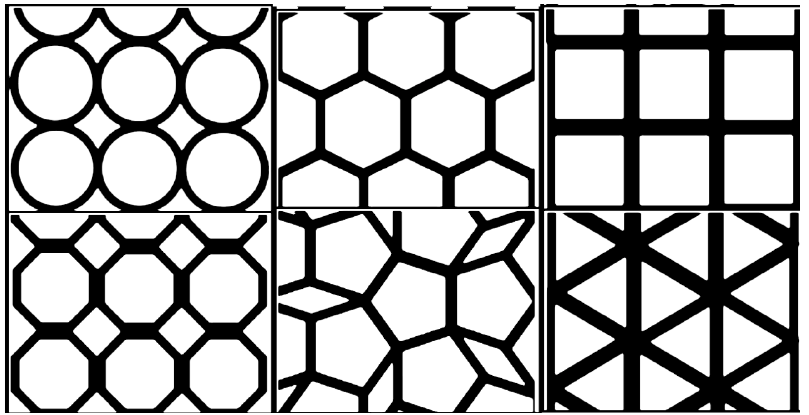
Figure 4. Triangular, square, pentagonal, hexagonal octagonal and, circular cross section